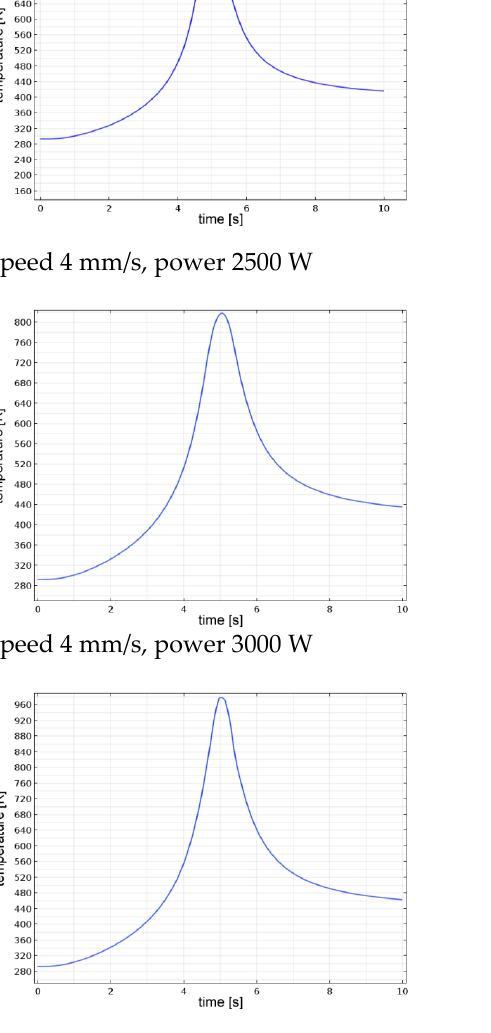
Figure 10. Simulated thermal history of the site of interest for each processing condition. Table 3. Peak temperatures, actual vs. predicted.